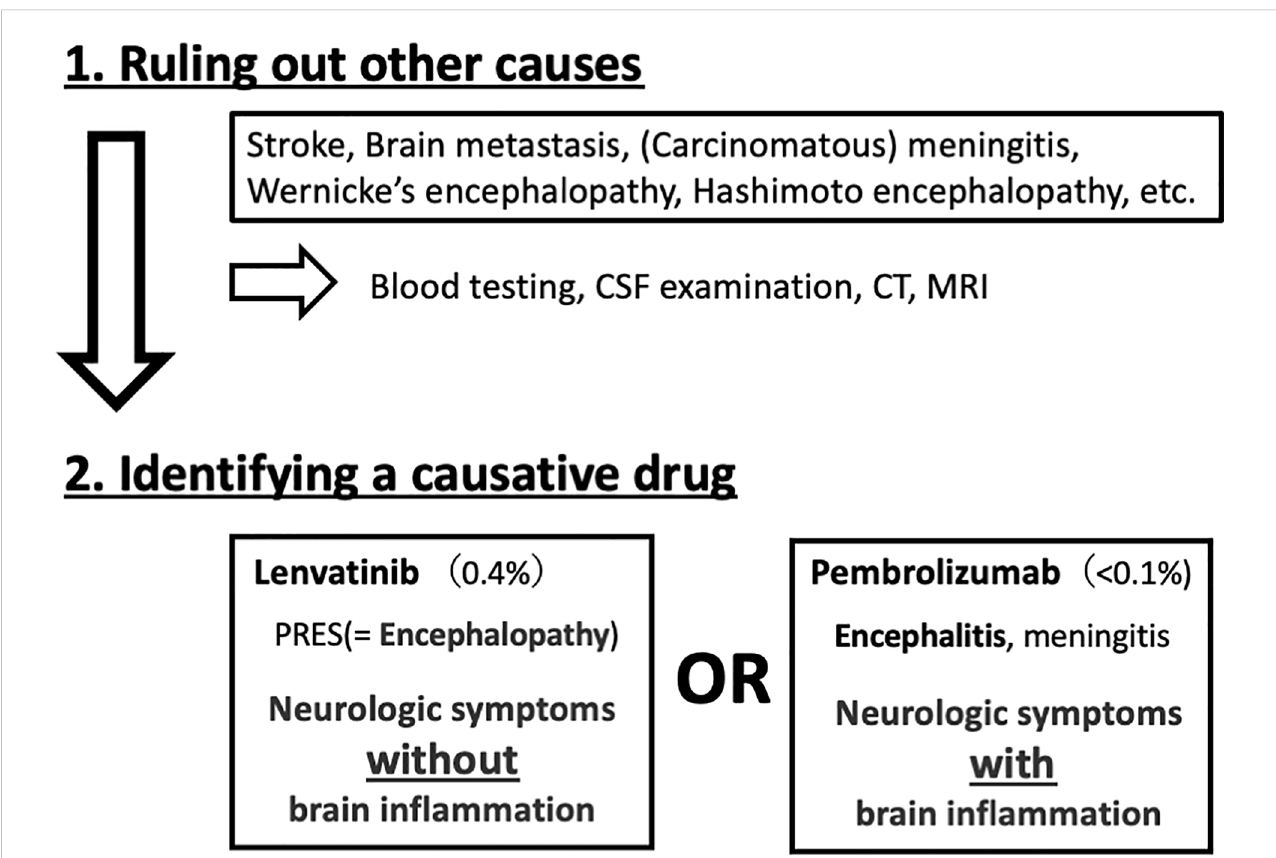
FIGURE 3 Steps to treat neurological adverse